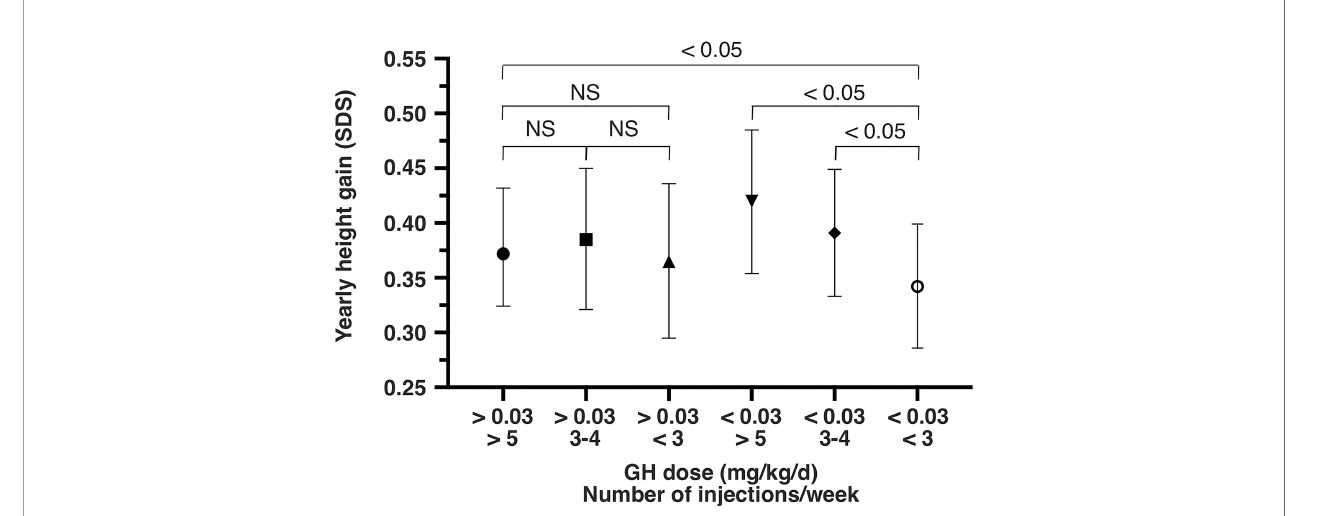
FIGURE 1 | Yearly height gain (SD score and 95% con fi dence interval) from the 12-month model, as a function of the mean daily rhGH dose (mg/kg/d) and the mean weekly number of injections. SDS, standard deviation score; NS, not signi fi cant; GH, growth